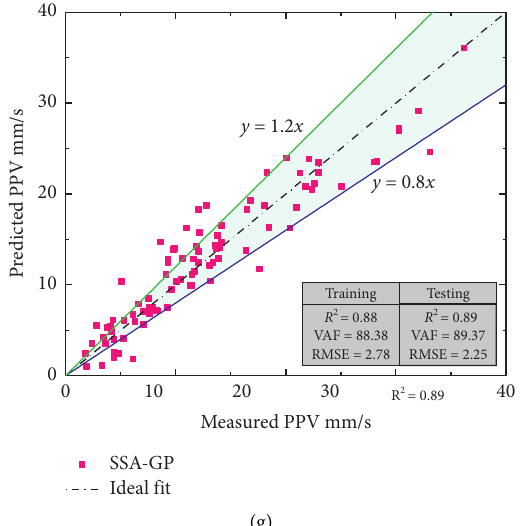
Figure 6: Measured versus predicted PPV value: (a) empirical model 1; (b) empirical model 2; (c) empirical model 3; (d) ANN model; (e) SVR model; (f) GP model; and (g) SSA-GP model.